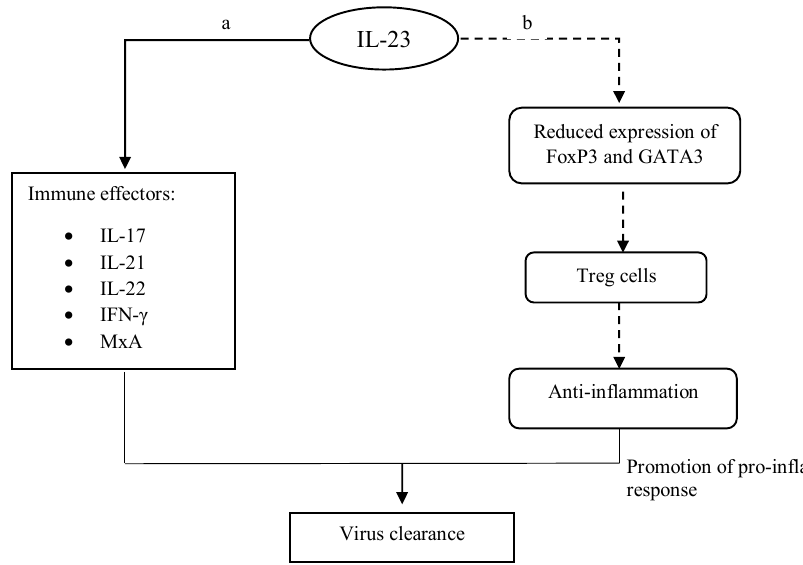
Figure 3. Pro-in fl ammatory reactions by IL-23. ( a ) IL-23 induces the expression of immune e ff ectors. Figure 3. Pro-inflammatory reactions by IL-23. ( a ) IL-23 induces the expression of immune effectors. Upon their expressions, those e ff ectors enhance the host immune response, which subsequently el- Upon their expressions, those effectors enhance the host immune response, which subsequently evates virus clearance. ( b ) IL-23 limits anti-in fl ammatory activities (dashed-line arrows) via the elevates virus clearance. ( b ) IL-23 limits anti-inflammatory activities (dashed-line arrows) via the downregulation of Treg. It later increases the pro-in fl ammatory response that aids in the removal downregulation of Treg. It later increases the pro-inflammatory response that aids in the removal of of virus particles. virus